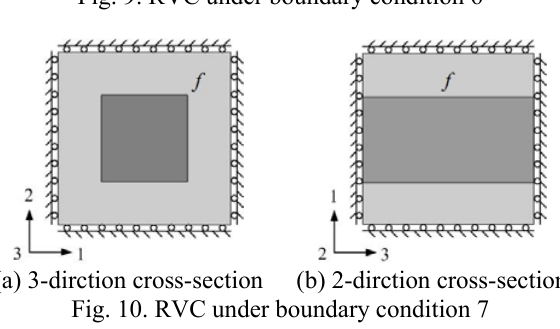
Fig. 10. RVC under boundary condition